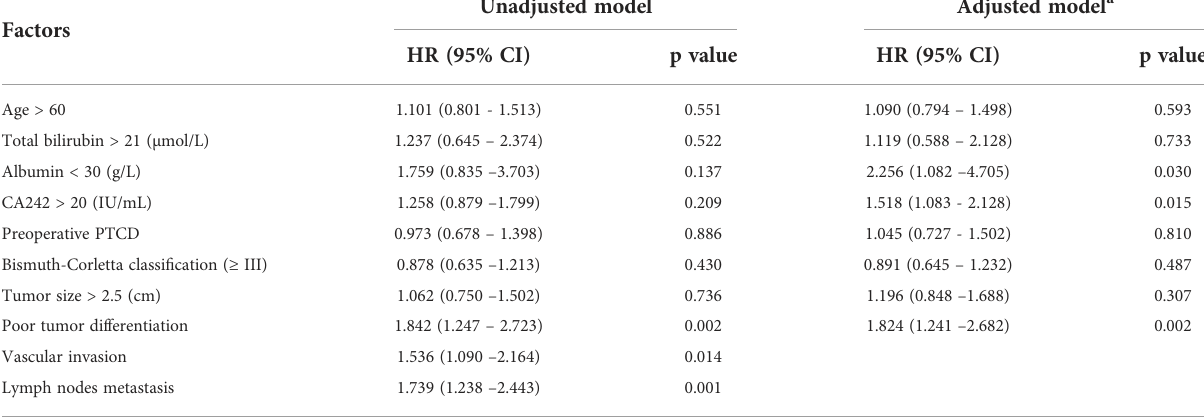
TABLE 4 Multivariable analysis of risk factors associated with overall